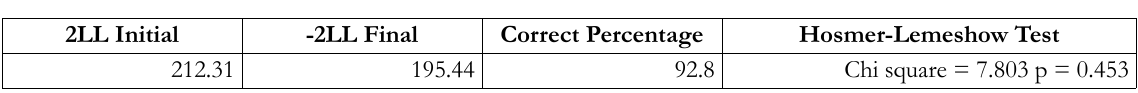
Table 5. Statistical summary of the logistic regression model